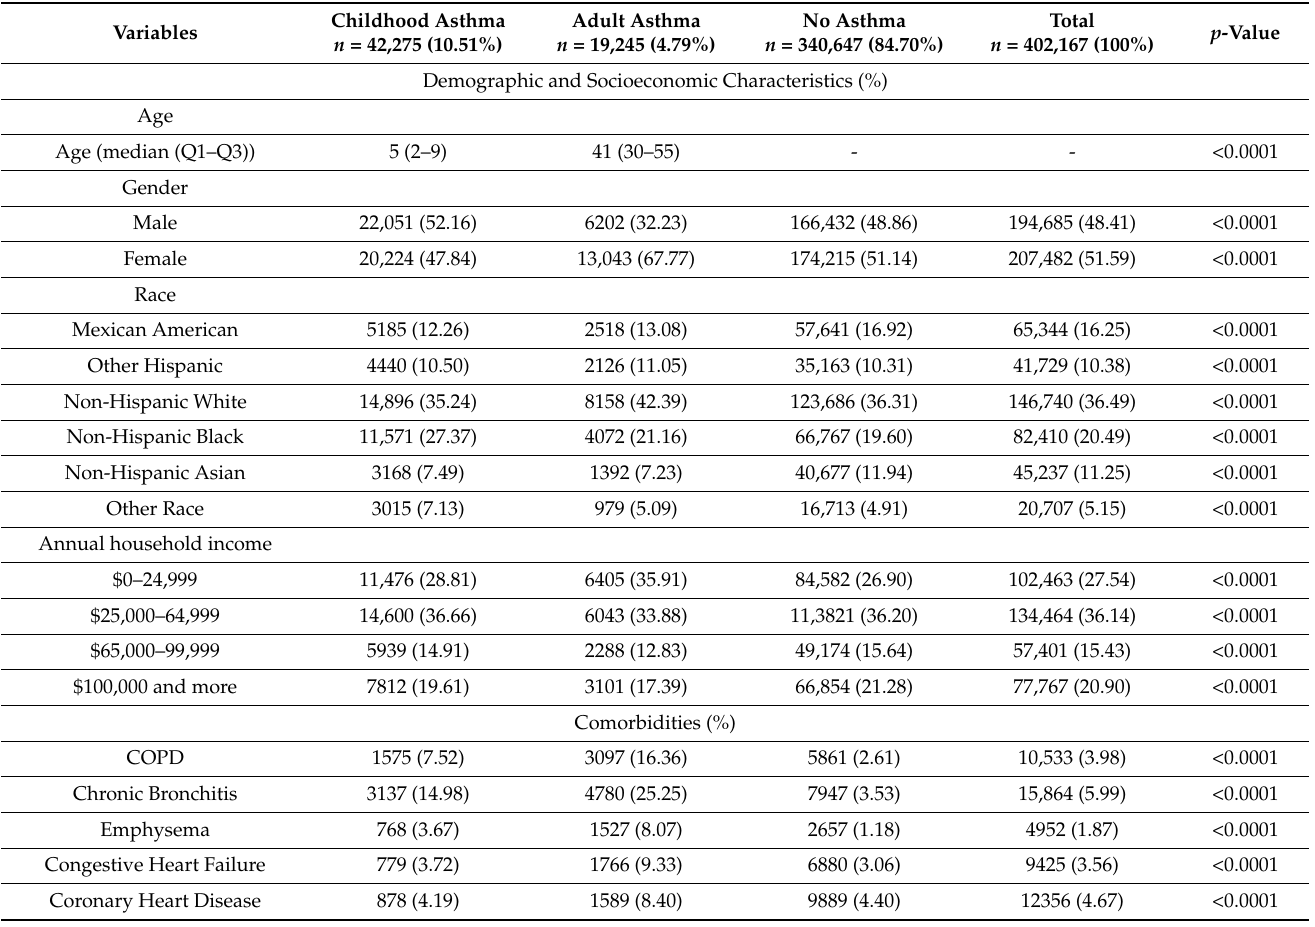
Table 1. Demographic and comorbidity characteristics of asthma amongst US population